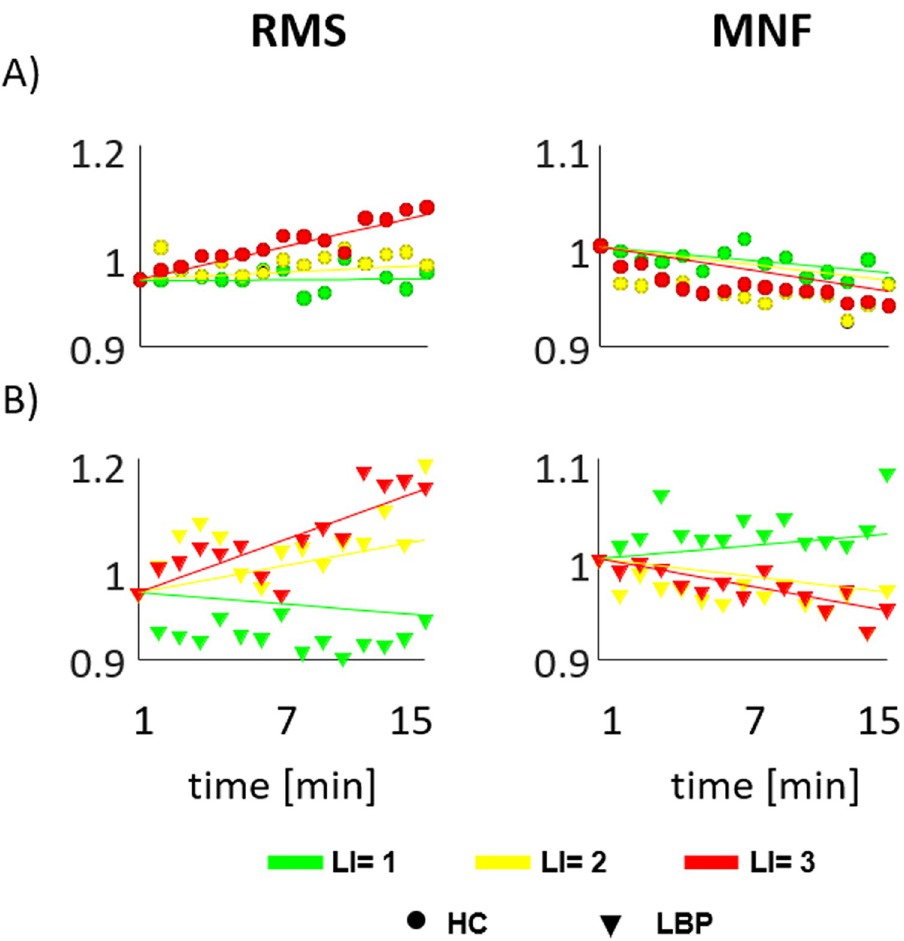
Fig 6. Mean value and regression line of sEMG parameters. Mean value of the root mean square (RMS) and mean frequency (MNF) considering the mean of all the repetitions within each minute of the whole-lifting cycle and the regression line for each risk level in both groups (healthy control (A) and people with Low Back Pain (B)). Each point on the graphs represents the group average extracted every minute.